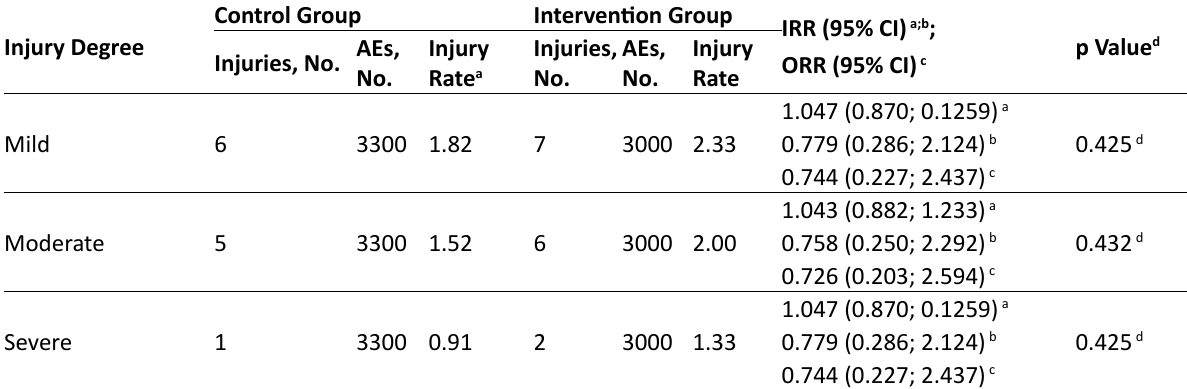
Table 1. Comparison of injuries of elbows of rock-climbers between the Control (n=44) and the Intervention Groups (n=40) within six months before the